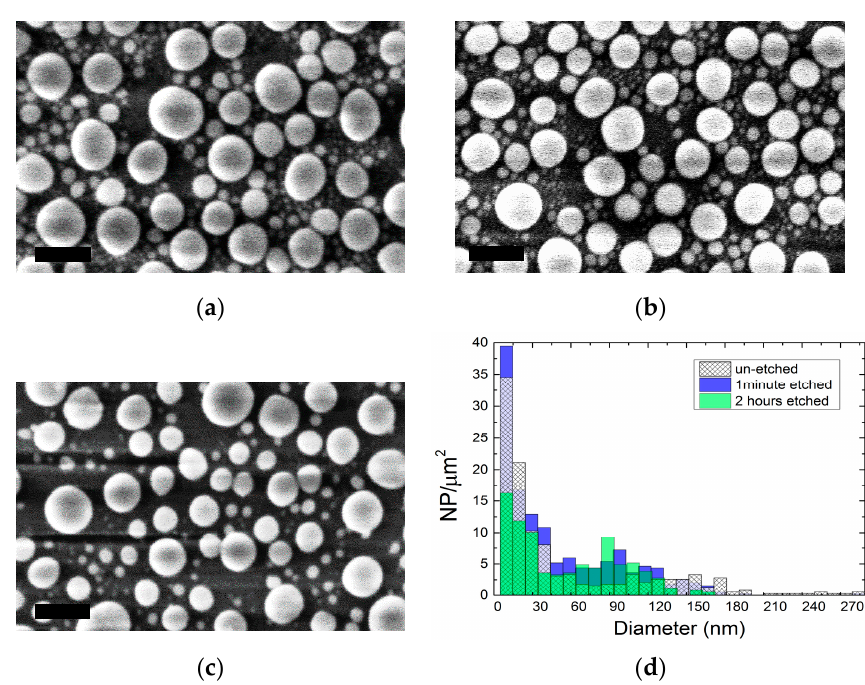
Figure 2. ( a ) Ga NPs evaporated on a glass substrate and immersed in an acidic bath for ( b ) 1 min; ( c ) 2 h. After 2 h, many of the smallest NPs have disappeared and the biggest ones have reduced their dimensions. ( d ) Histograms obtained from the SEM images. Scale bars are all 200 nm in length.